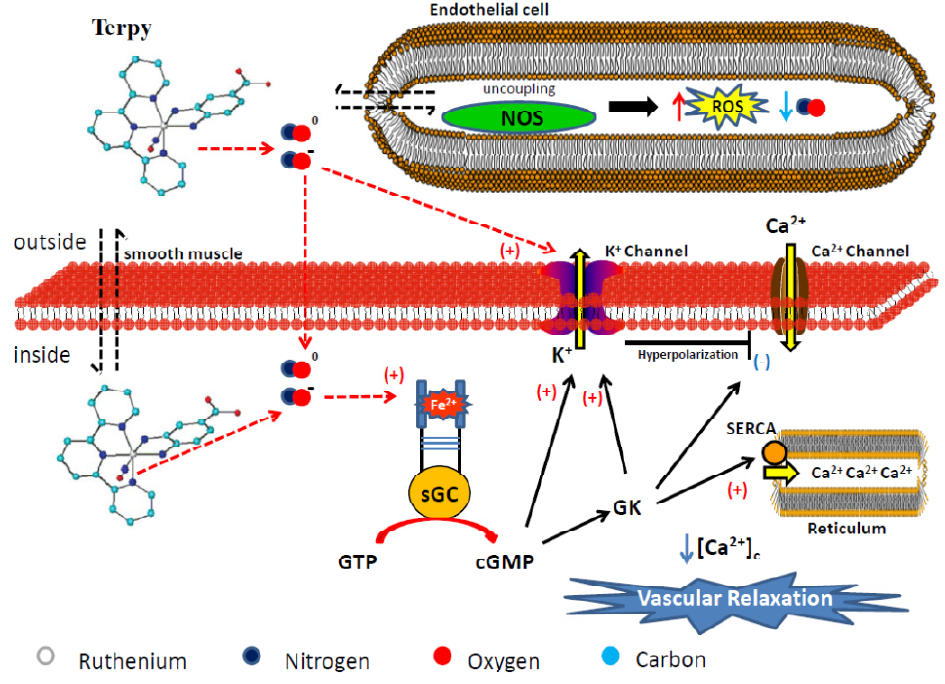
Figure 8. Proposed nitric oxide release and vasodilation mechanism induced by Terpy ([Ru(tpy)(NH.NHq)NO] 3+ ). The colored circles represent atoms in the chemical structure. The hydrogen atom has been omitted in the structure. Legend: sGC = soluble guanylyl cyclase, GK = G Kinase Protein, SERCA = sarco/endoplasmic reticulum